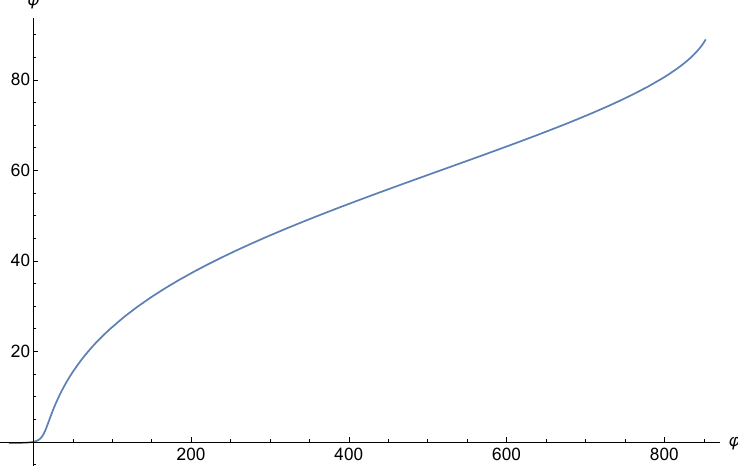
Figure 5. The relation of the canonical φ with the non-minimal ϕ when κ (cid:39) 0.3 and ξ ∼ 10 − 5 . √ ξ φ 0 / m P (cid:39) 0.25 < 1. According to the discussion With these values we see that after Equation (13), the potential approximates a decaying exponential of strength κ